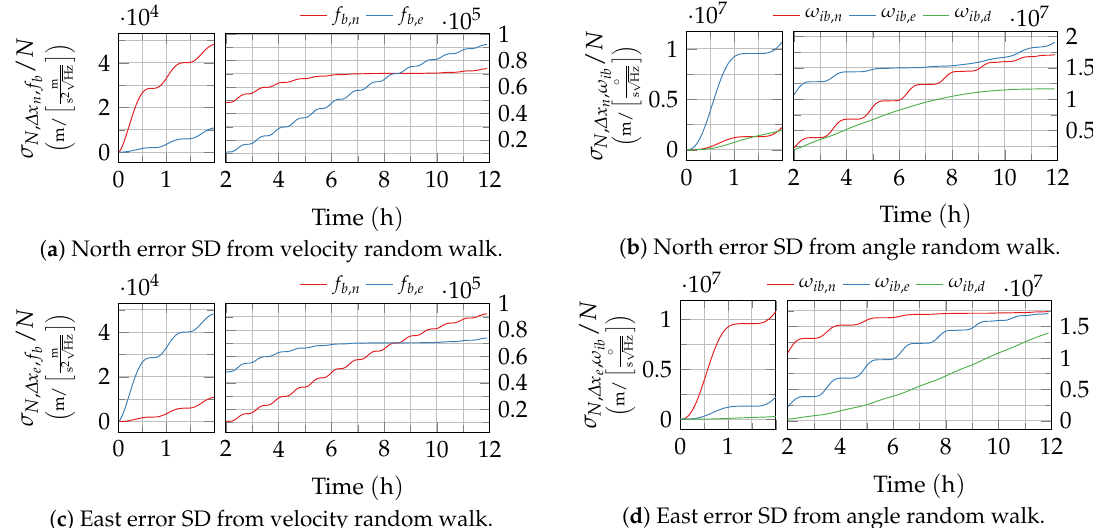
Figure 4. Position error growth from the angular velocity random walk noise. The time axis of the plots is split to provide a better resolution of the short-term